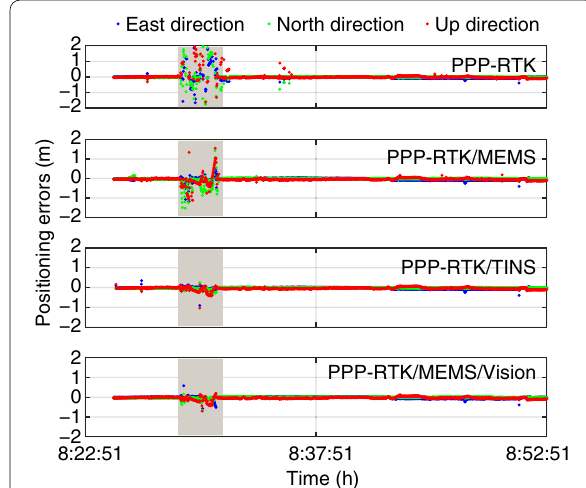
Fig. 9 Positioning series of PPP-RTK/MEMS, PPP-RTK/Tactical grade INS (PPP-RTK/TINS) and PPP-RTK/MEMS/vision